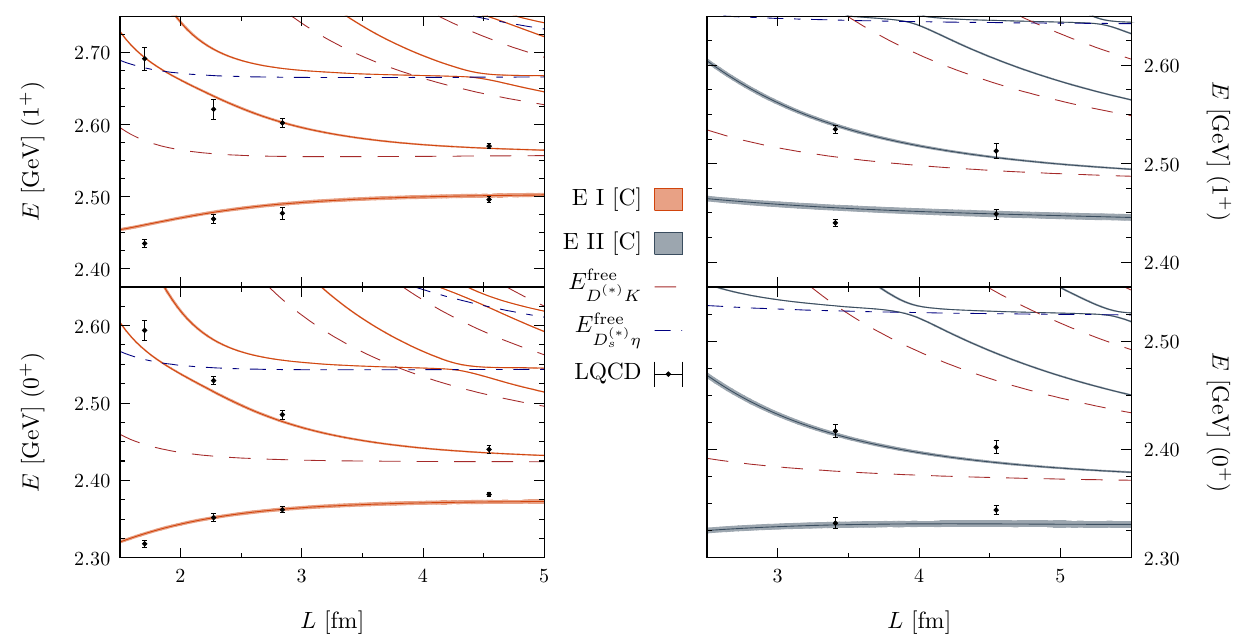
Fig. 3 Same as Fig. 1, but in this case the predictions have been unitarized LO HMChPT amplitudes. The bestfit UV cutoff in this sce- nario and some derived quantities are given in the Set C rows of Table 3 obtained after neglecting the contribution to the amplitudes of the exchange of intermediate even-parity charmed-strange CQM mesons, i.e., setting c = 0 and evaluating the energy-levels using finite-volume ( 2317 ) are now much more similar. D s 1 ( 2460 ) and D ∗ s 0